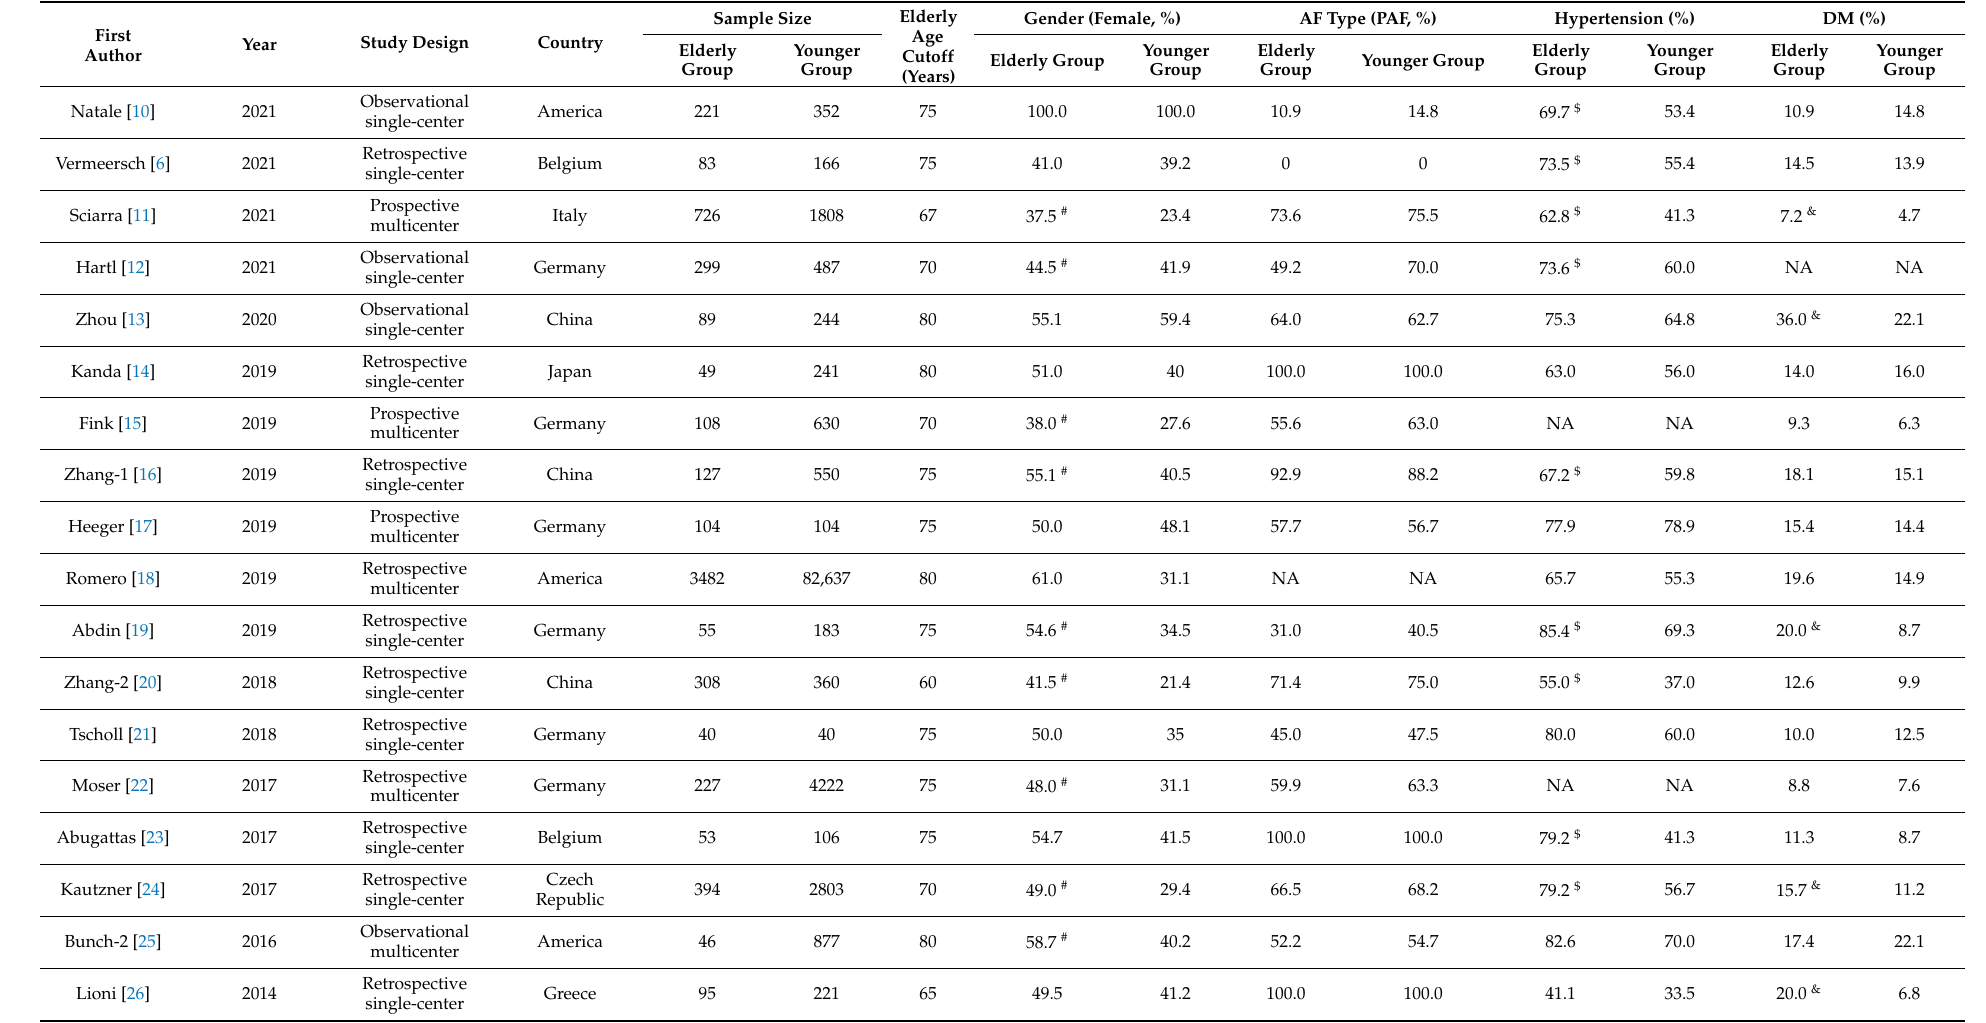
Table 1. Baseline characteristics and procedure-related indices of eligible